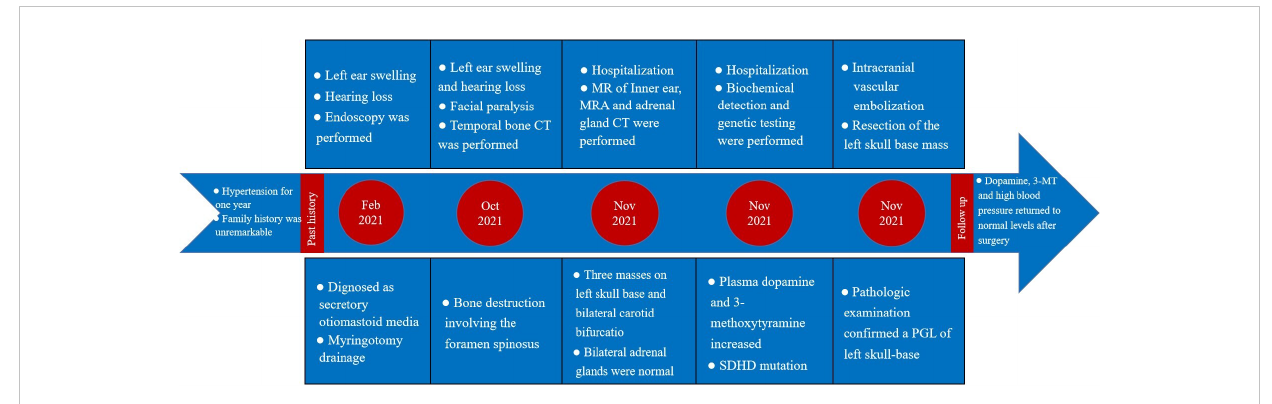
FIGURE 1 Case treatment process